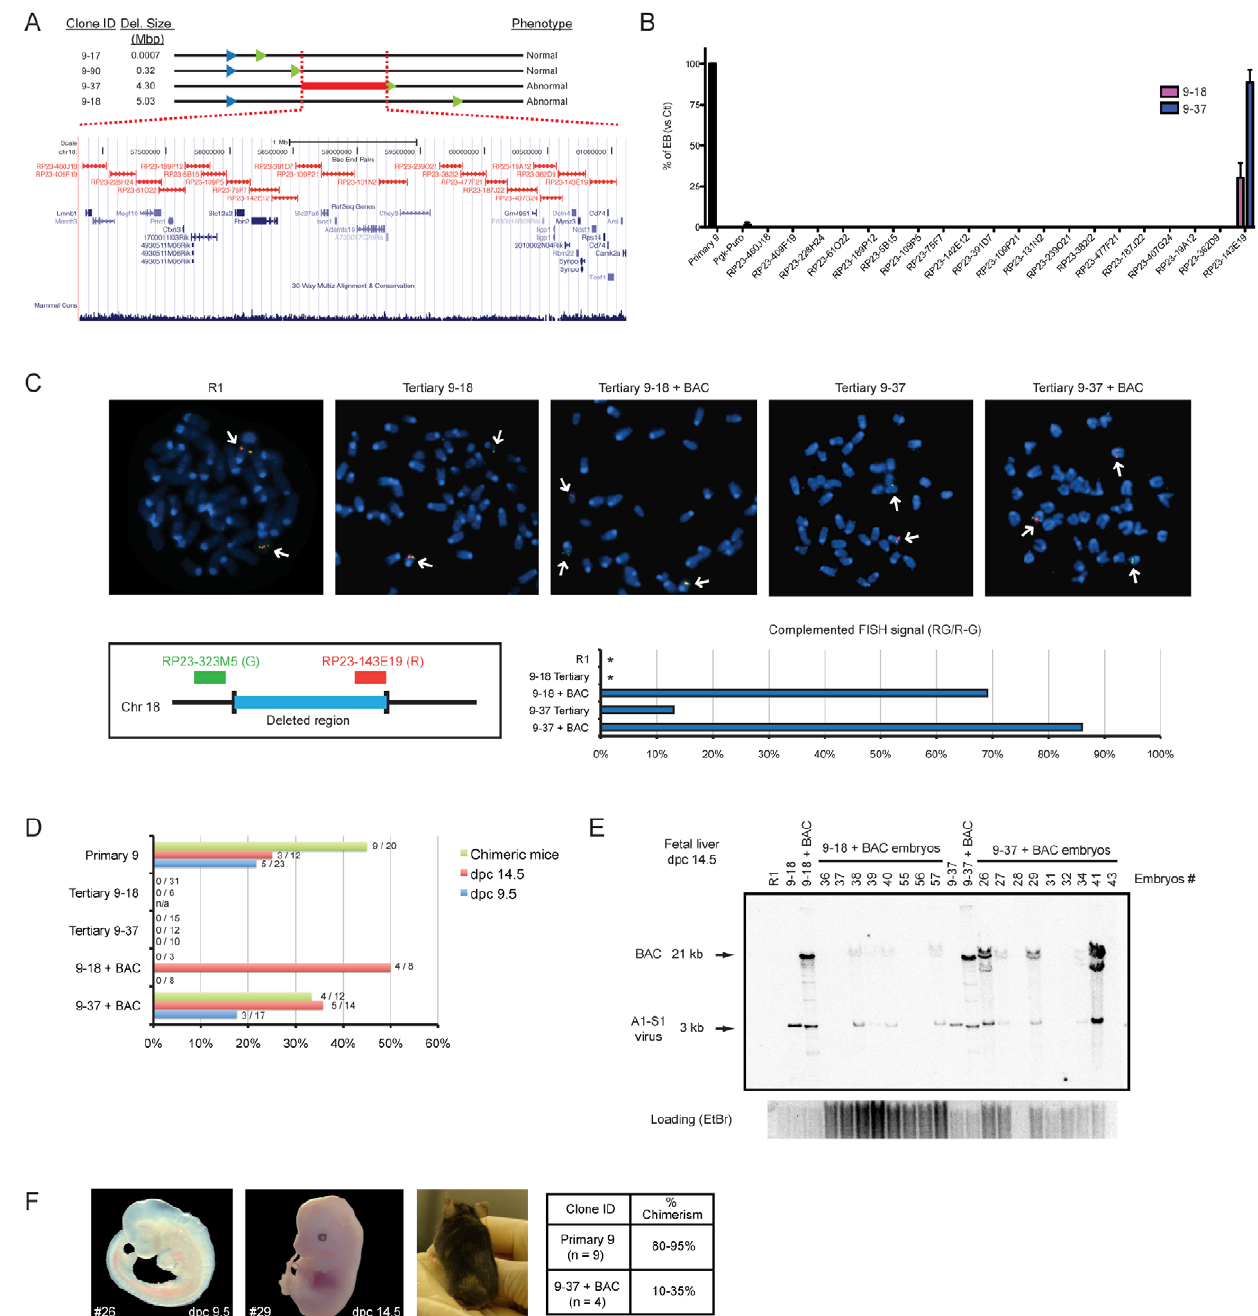
Figure 6. Rescue of differentiation defects of tertiary clones from DelES family 9. (A) Genomic representation of minimal deleted region leading to a differentiation phenotype in family 9 tertiary clones. Schema adapted from UCSC Genome Browser (B) Embryoid body differentiation assay following stable transfections of modified BACs covering the region of interest. Only BAC RP23-143E19 transfection could rescue the differentiation defect in tertiary clones 9–37 (complete) and 9–18 (partial). Bars represent average EB number (transfected tertiary clones normalized to control primary clone) from four independent transfections (n=4 tests per experiment). Complete and partial complementation leads to at least 300X and 100X EB over background EB number, respectively. (C) FISH analysis of BAC-transfected clones. Upper panel : representative metaphase FISH images for selected clones. Lower left panel : FISH assay design, using two BACs as probes. RP23-323M5 is the control probe, which hybridizes outside of the deleted region, and is labeled with a green fluorescent marker (G). The BAC of interest, RP23-143E19 is labeled with a red fluorescent marker (R). Lower right panel : Complemented FISH signal reported as the proportion of cells which display a yellow (Red + Green: RG) signal combined with Red and Green (R–G) signals over the total number of cells analyzed (n=100 interphase cells and n=10 metaphase cells). *, no RG + (R–G) cell observed. (D) In vivo contribution of BAC-transfected and control clones to chimeric animals was evaluated by PCR for E9.5 and E14.5 embryos and by coat color chimerism for adult mice. Values are represented as proportion of neomycin positive embryos over total number of embryos analyzed and the proportion of adult chimeric mice over total number of newborns. Data related to non-transfected tertiary clone 9–18 has been previously reported [23]. (E) Southern blot analysis of DNA extracted from chimeric dpc14.5 fetal livers. Eco RV restriction digest combined with a neo probe revealed a 3 Kb and a 21 Kb fragment, corresponding to the primary anchor virus and modified BAC ( Eco RV restriction sites in both insert and backbone), respectively. (F) Pictures of representative embryos, chimeric mouse and table of average chimerism estimated by coat color determination (newborn and adult mice). Dpc, days post coitum. doi:10.1371/journal.pgen.1001241.g006 PLoS Genetics |